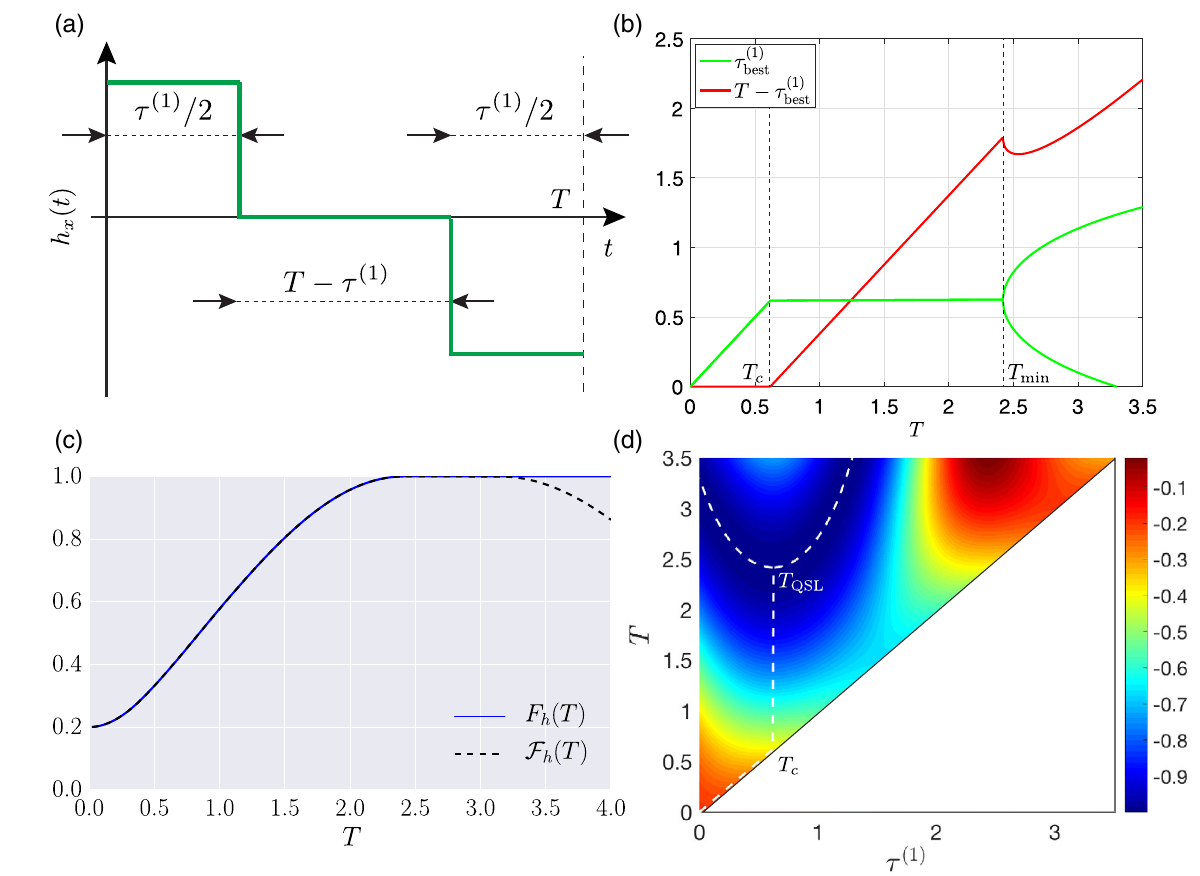
FIG. 4. (a) Three-pulse variational protocol which allows us to capture the optimal protocol found by the computer in the 1 Þ overconstrained and the glassy phases of the single-qubit problem. (b) τ ð (green) with the nonanalytic points of the curve marked by best ≈ 0 . 618 and T ≈ 2 . 415 . (c) Best fidelity obtained using SD (solid blue) and the variational dashed vertical lines corresponding to T c QSL ansatz (dashed black). (d) The variational infidelity landscape with the minimum for each T slice designated by the dashed line which shows the robustness of the variational ansatz against small